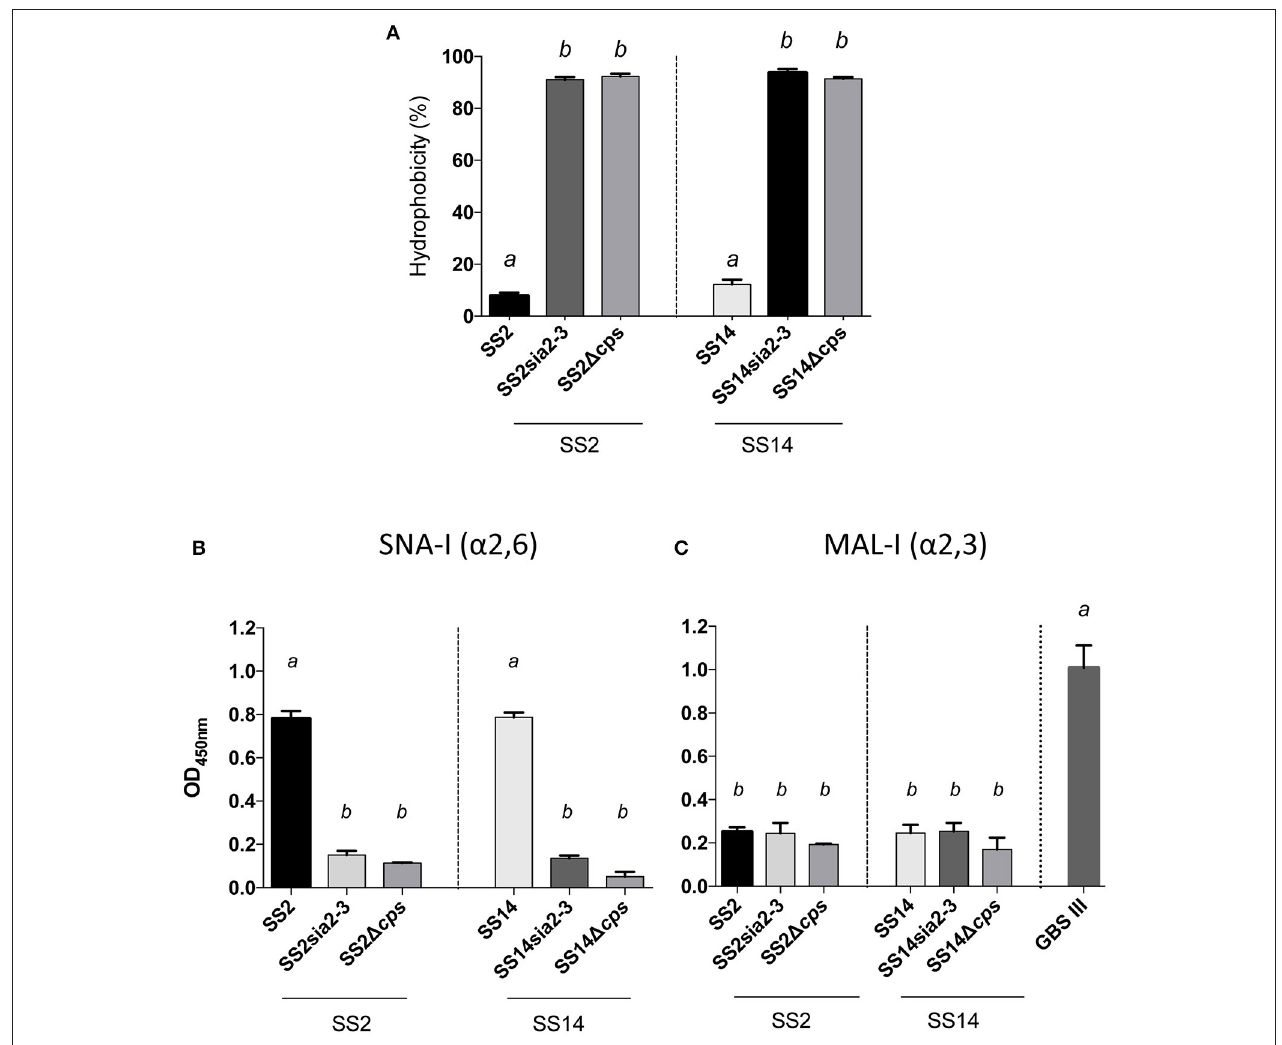
FIGURE 5 | Capsular polysaccharide (CPS) expression levels and sialic acid linkage in S. suis serotype 2 and 14 mutants carrying exogenous α -2,3-sialyltransferase. (A) Hydrophobicity (%) of the wild-type S. suis serotype 2 (SS2) and 14 (SS14) strains, the SS2sia2,3 ( 1 cps2N / cpsK ) and SS14sia2,3 ( 1 cps14N / cpsK ) mutants carrying the GBS α -2,3-sialyltransferase ( cpsK ). The non-encapsulated mutants SS2 1 cps and SS14 1 cps were used as control strains. (B,C) Whole-bacterial cell enzyme-linked lectin assay (ELLA) was performed to detect α -2,3 or α -2,6 capsular sialic acid linkage in SS2sia2,3 and SS14sia2,3 mutant strains. Whole